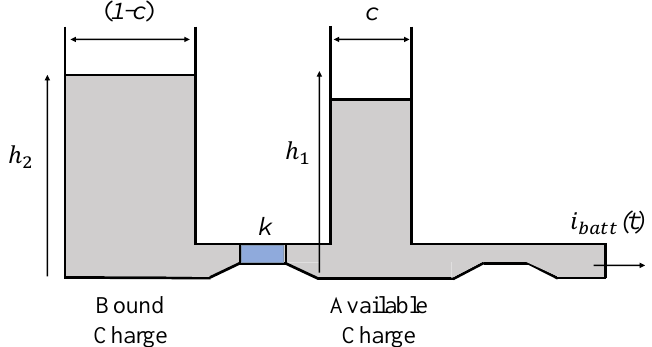
Figure A1. Kinetic battery model: the battery is represented as structure composed by two charge wells: bound charge and available charge. The capacity ratio, c , defines the charge